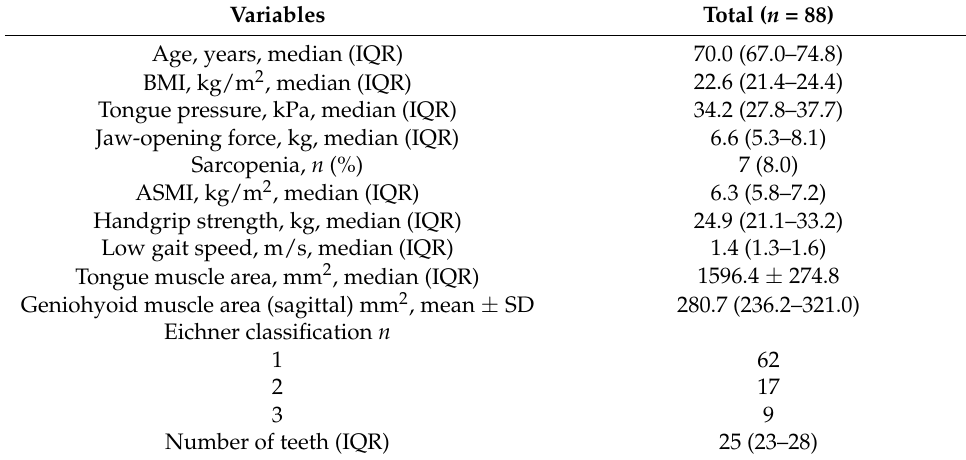
Table 1. Characteristics of